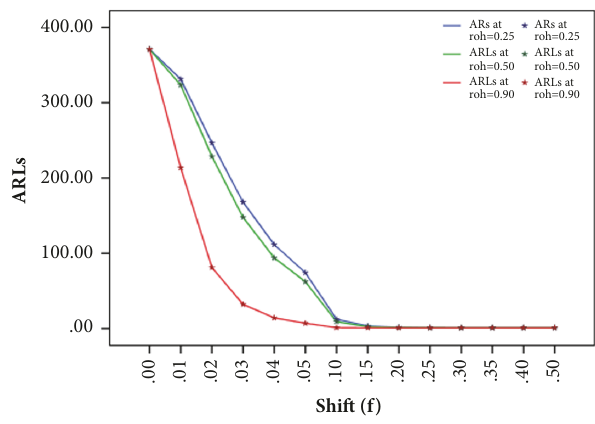
Figure 11: ARLs for proposed repetitive EWMA-RSS control chart using Khan et al. [8] ratio estimator, when 𝑟 𝑜 = 370 at 𝜆 =